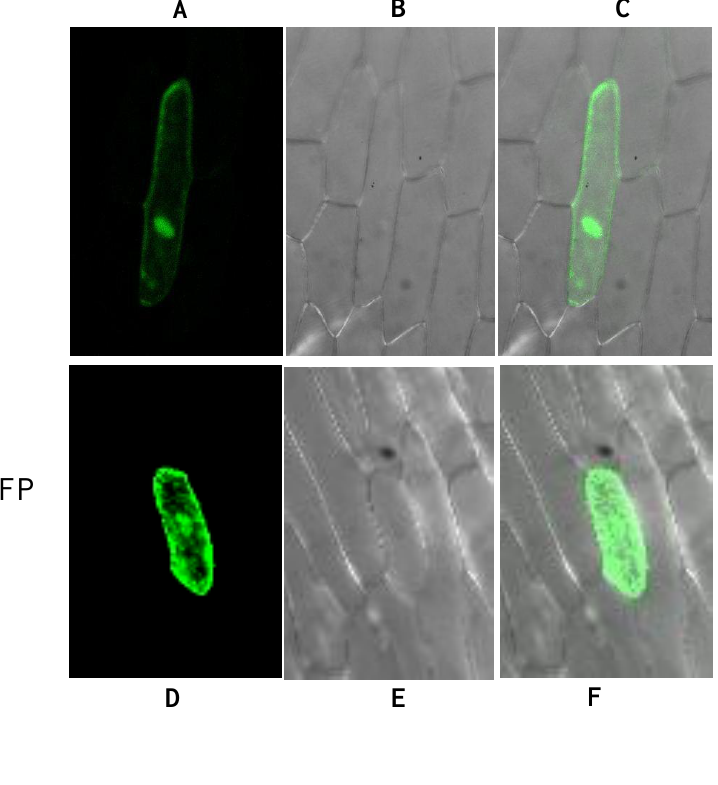
Figure 8. Subcellular location analysis of TaLEA1 transformed protein. The full-length coding region of TaLEA1 (without the stop codon) was fused with the N -terminus of the GFP protein to generate the fusion gene TaLEA1 - GFP . The fusion construct for TaLEA1-GFP and the GFP control plasmid were introduced into onion epidermal cells by particle bombardment. A , D : GFP fluorescence; B , E : onion peel cells imaged under bright field; C , F : merge of bright field and